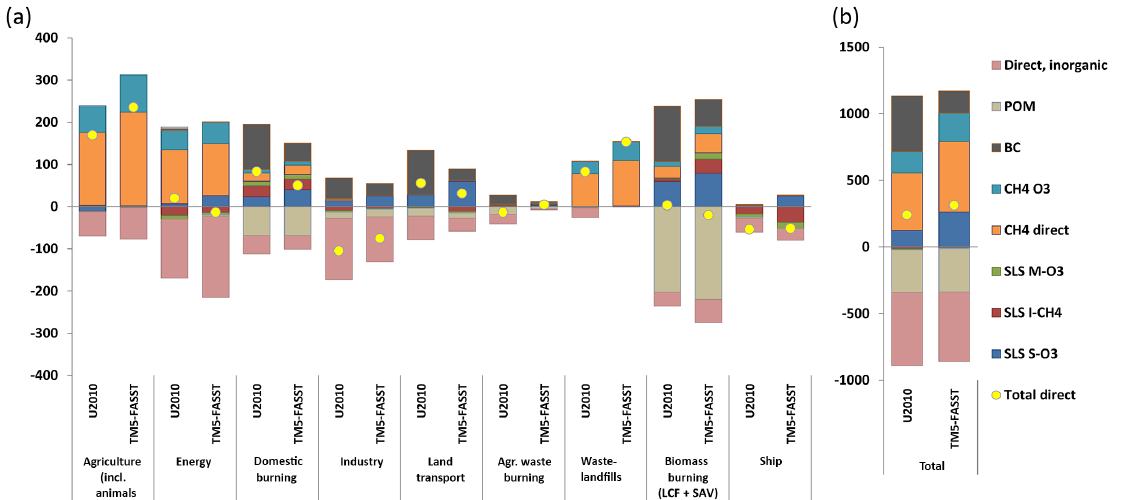
Figure 15. Year 2000 radiative forcing from Unger et al. (2010), based on EDGAR year 2000 emissions and from TM5-FASST applied to RCP year 2000 (a) , broken down by sector and by forcing component. Biomass burning includes both large-scale fires and savannah burning; (b) total over all sectors. SLS S-O 3 shows the direct contribution of short-lived species (SLS) to O 3 ; SLS I-CH 4 shows the indirect contribution from SLS to CH 4 ; SLS M-O 3 shows the indirect feedback from SLS on background ozone via the CH 4 feedback. CH 4 O 3 shows the feedback of emitted CH 4 on background O 3 .